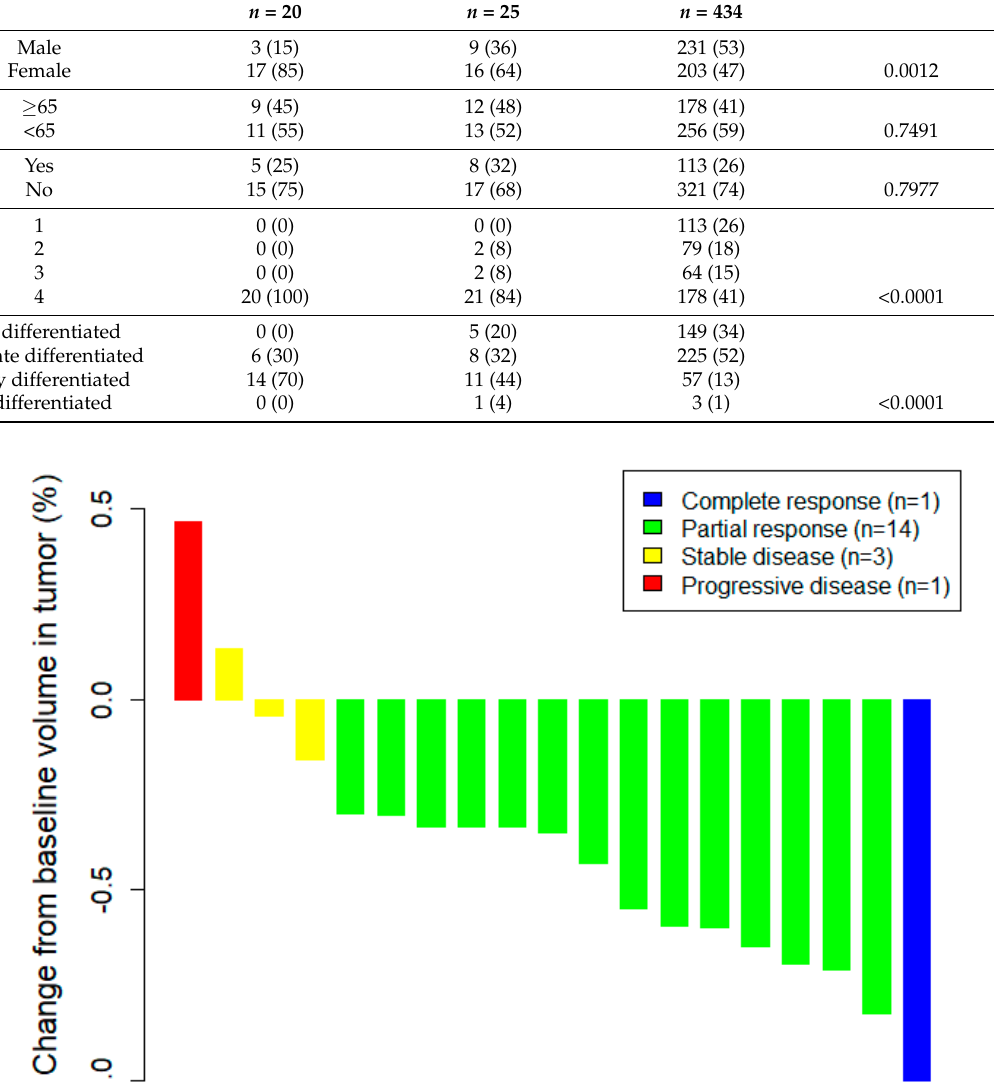
Figure 4. Waterfall plots of ROS1 translocated cases treated with crizotinib. A total of 19 ROS1 rearranged NSCLC patients received crizotinib treatment, including 1 case with complete remission, 14 cases showing partial regression, 3 cases under stable disease, and 1 case rapidly progressing.